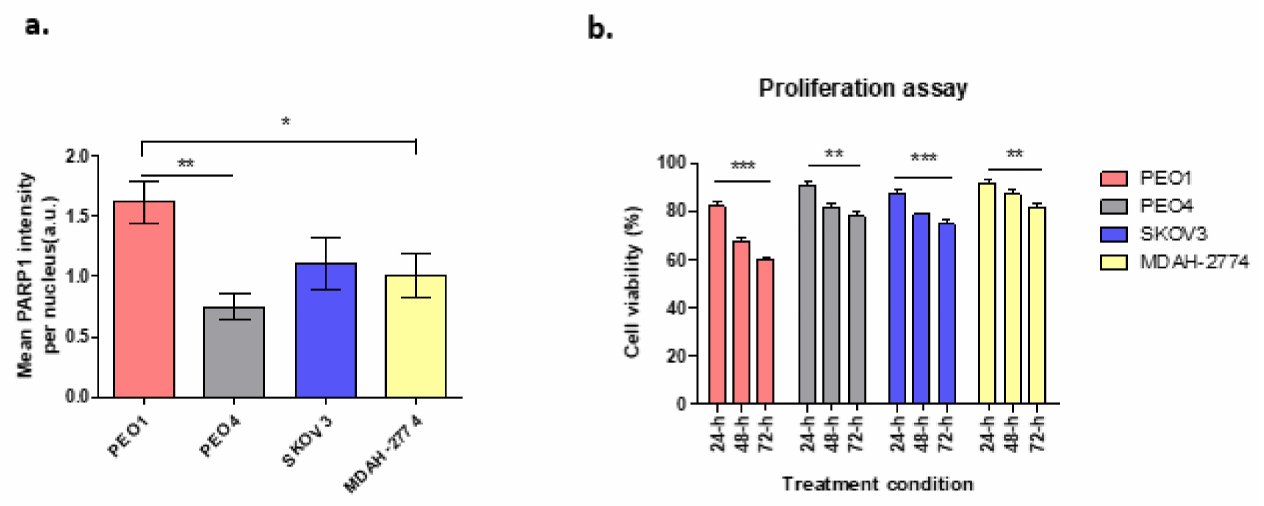
Figure 1. ( a ) PARP1 enzyme expression in cell lines treated with H 2 O 2 . PEO1: ** p = 0.0024, * p = 0.042; ( b ) Cell viability following rucaparib treatment at 24–72 h. PEO1 cells showed high level of decrease in cell viability after 72-h treatment when compared to other cell lines. However, the decrease level of cell viability in SKOV3 was still higher compared to PEO4 and MDAH-2774. Comparisons between 24 and 72-h of treatment; PEO1: *** p = 0.0002, PEO4: ** p = 0.0037, MDAH-2774: ** p = 0.0096, and SKOV3: *** p =